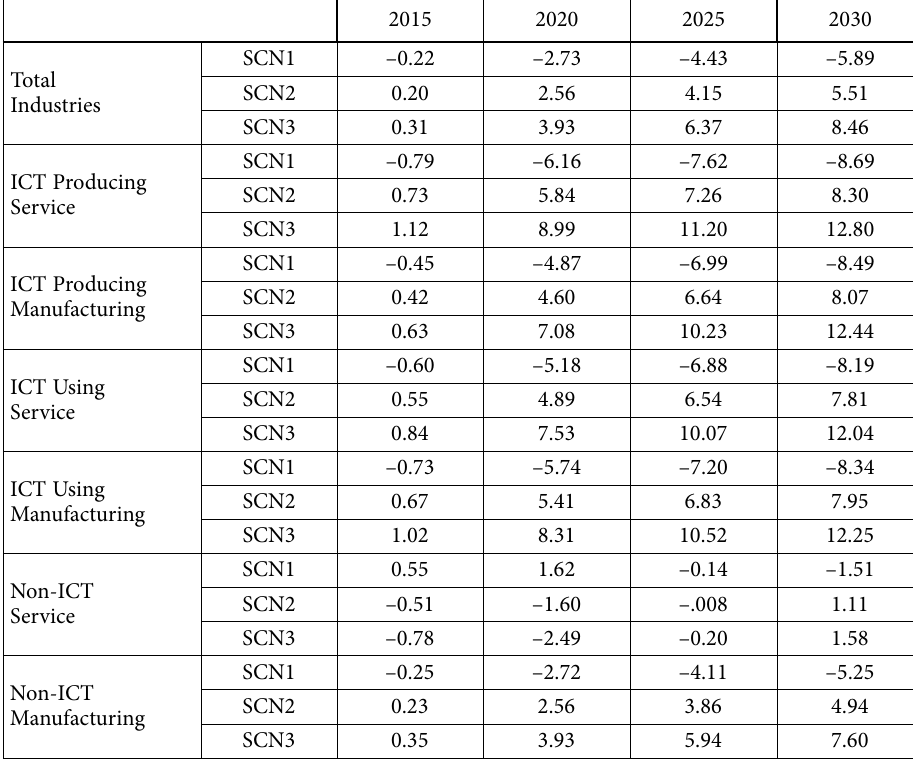
Table 2. Industrial outputs differences from the BAU scenario by sector